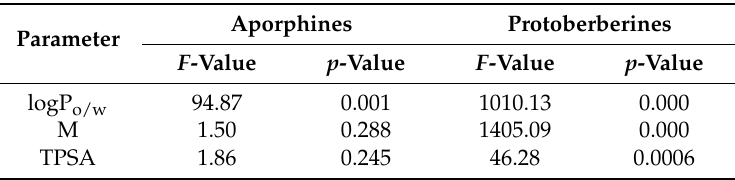
Table 2. Statistical p - and F -values obtained for the tested